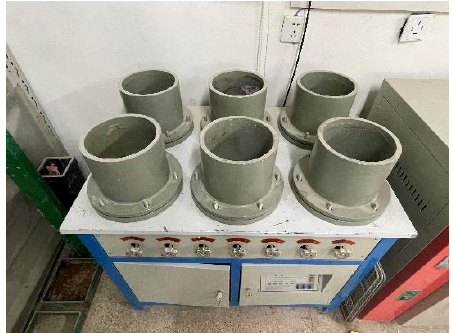
Figure 5. Concrete anti-permeability apparatus.